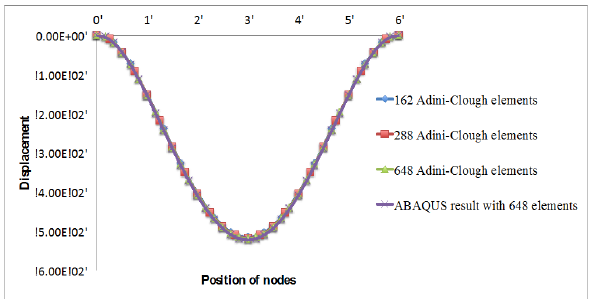
Figure 7: Transverse displacement u 3 distribution along the long edge for a single-layer shell with Adini-Clough elements.